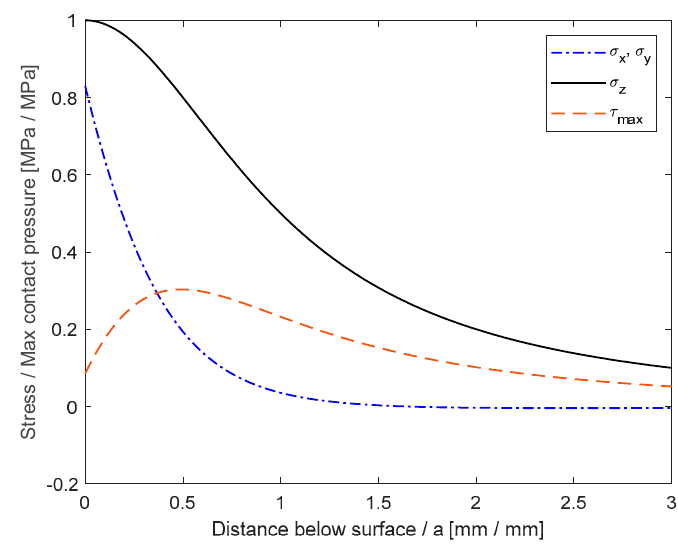
Figure 5. Subsurface stresses distributions.